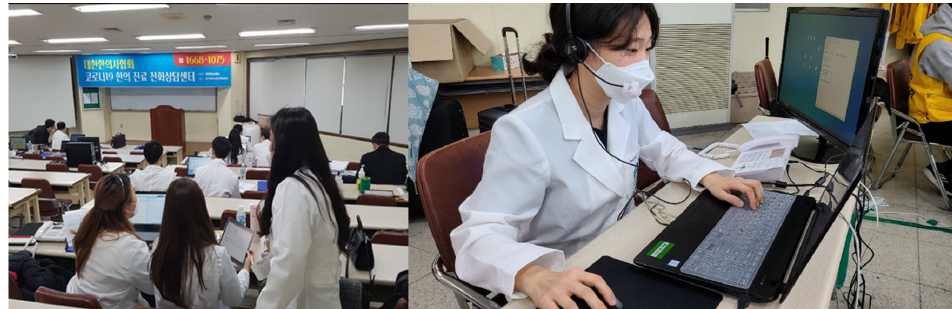
Figure 2. The COVID-19 telemedicine center of Korean medicine (KM). Note. The center has been treating more than 20% of confirmed COVID-19 patients in Korea with telemedicine since 9 March. 2. Korean Medicine (KM) Doctor’s Mental Health Instruction Manual in Telemedicine for COVID-19